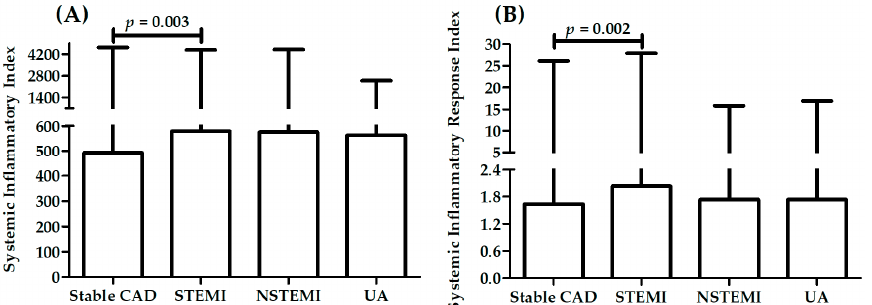
Figure 5. Differences in SII ( A ) and SIRI ( B ) between patients with different diagnosis.